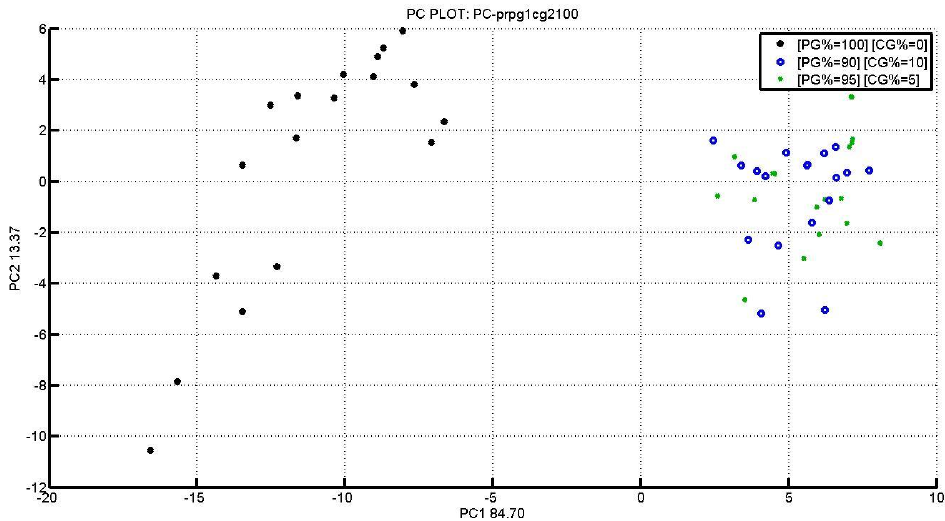
Figure 2. PG1 and CG2 PCA Score PLOT with different crust percentages.